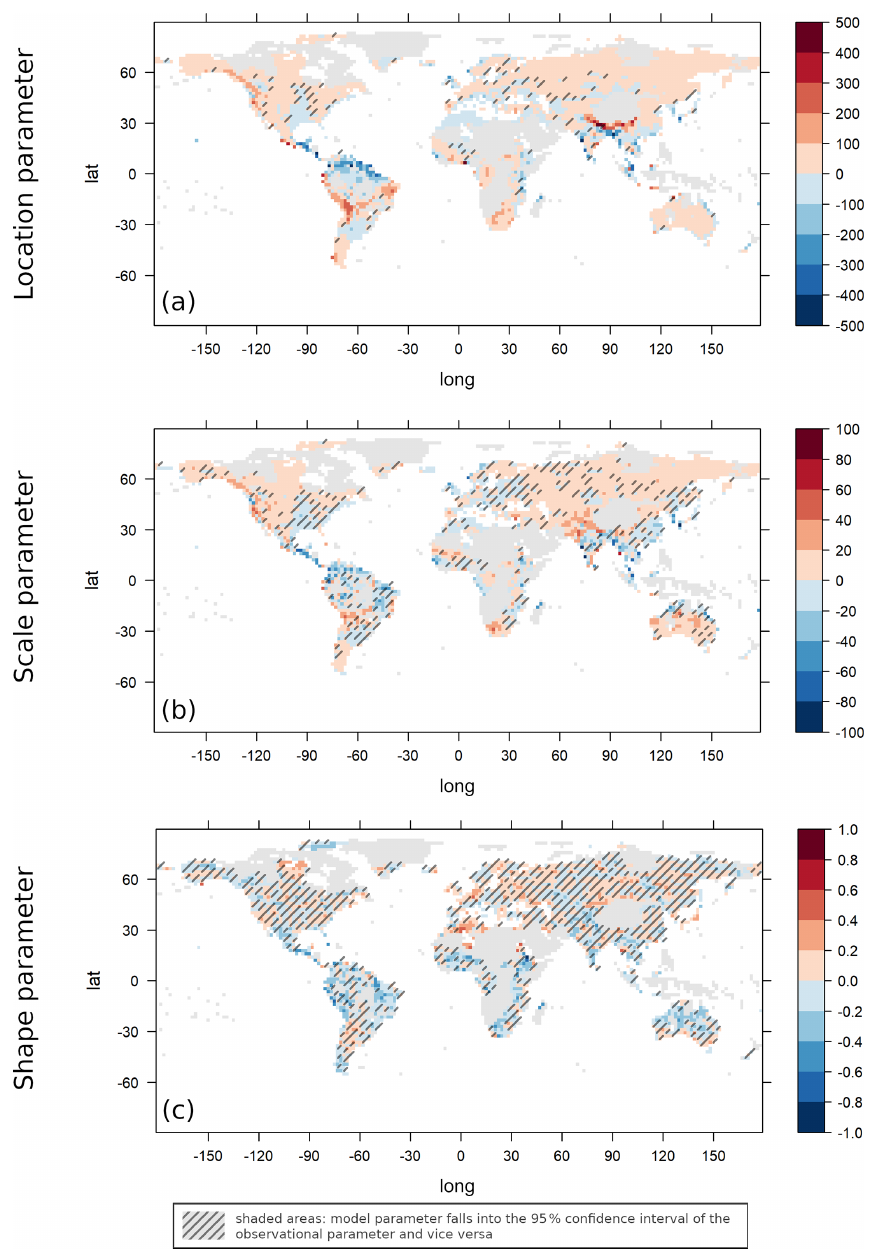
Figure 5. Difference between AWI-ESM model and observational GEV parameter estimates: location parameter (a) , scale parameter (b) and shape parameter (c) . Values exceeding the scale limits are truncated. Values are given in millimetres per